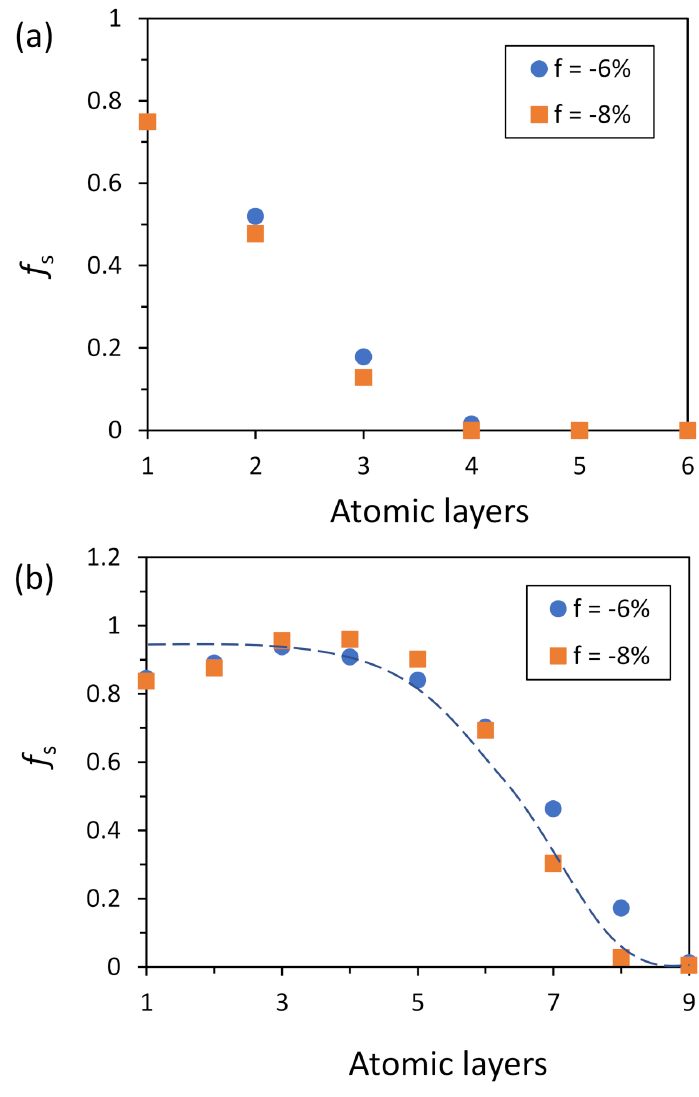
Figure 21. Comparing solid fractions at onset and end of the nucleation. Fraction of solid atoms ( f s ) in the individual layers for the systems with − 6% and − 8% misfit is plotted ( a ) at the onset of heterogeneous nucleation ( t 1 ); and ( b ) at the end of nucleation ( t 2 ). As a good approximation, it can be assumed that all the systems with varying misfit at their perspective nucleation temperature ( T n ) have the same level of atomic ordering at both the start and the end of heterogeneous nucleation. The dashed line in ( b ) represents the general trend of fraction of solid atoms corrected for the underestimate due to the limitation of local bond-order analysis